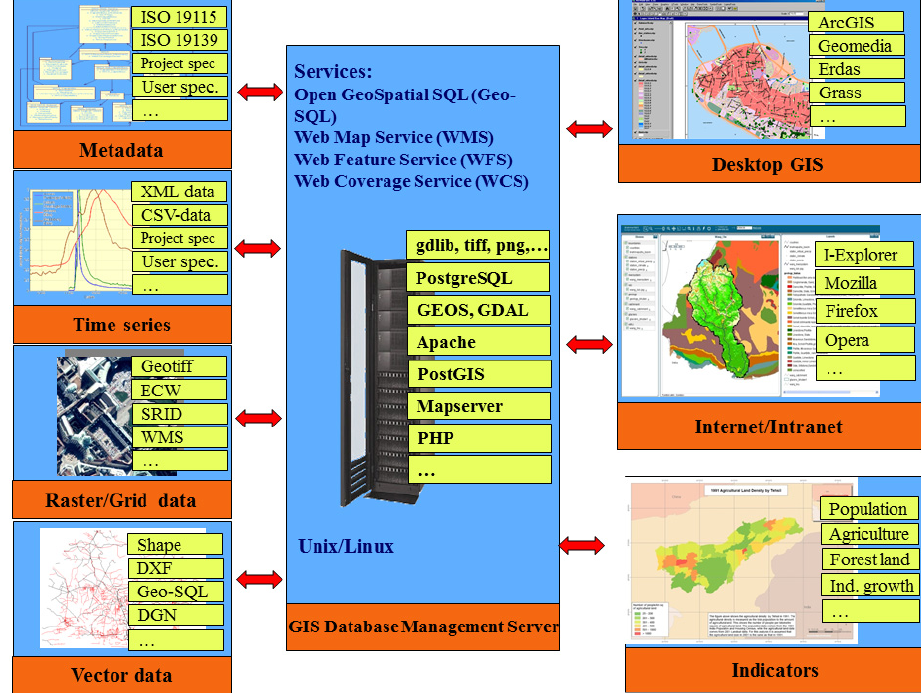
Figure 3. IWRMS data management architecture and data